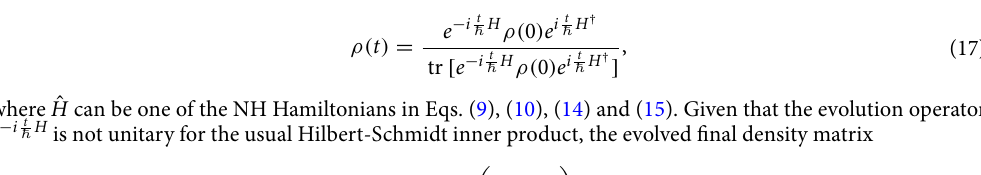
where r , u , v and θ are four independent real parameters; P is still the parity operator. The eigenvalues of H PPH and uv − r 2 sin 2 θ and i ε ′ ± , respectively. The energy differences of the two systems are H APPH are ε ′ ± = r cos θ ± (cid:31) which are either purely real or imaginary. So we classify them into two phases of the (anti-)P-pseudo-Hermitian systems, denoting as PPH(real), PPH(imaginary), anti-PPH(real) and anti-PPH(imaginary), referring Figs. 1(b)